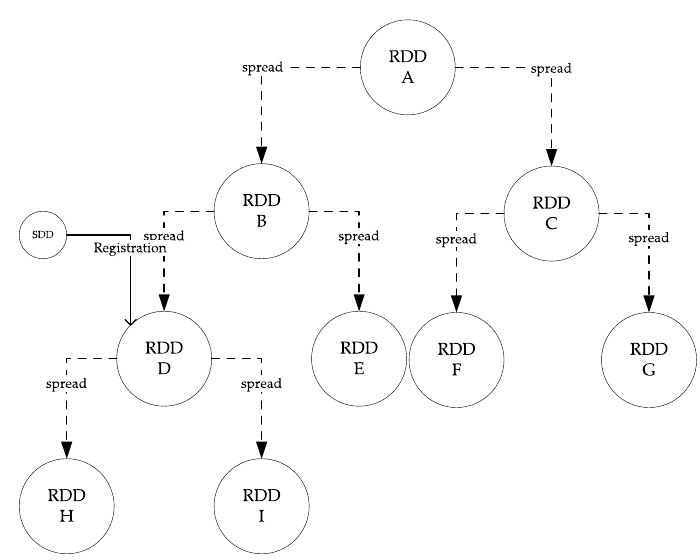
Figure 8. An example where more than half of the total number of RDDs cannot participate in validation.